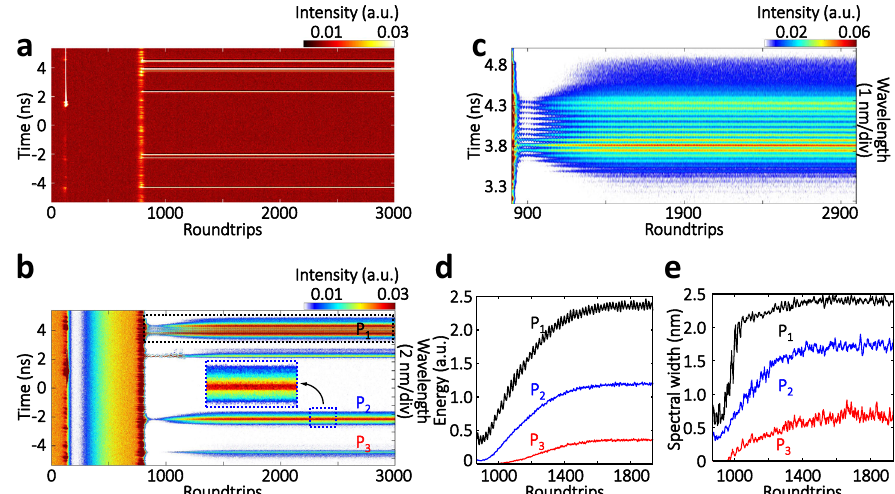
Fig. 3 MUST birth of the multipulse STML started from a single shockwave. a Temporal evolution. Here, partial MUST evolution is presented, whereas the full data set has been covered in Supplementary Figure 6. b Corresponding spectral evolution. In this case, different pulse clusters coexist in the same roundtrip, including soliton-molecule with strong binding (P 1 ), soliton pair without strong binding (P 2 ) and ordinary soliton (P 3 ). Inset shows the close-up of P 2 . c Close-up of the spectral evolution of the soliton-molecule birth, as indicated in b . d Energy evolutions of pulses P 1 – P 3 . e Spectral width evolutions of pulses P 1 – P 3 . More details have been provided in Supplementary Note 5.